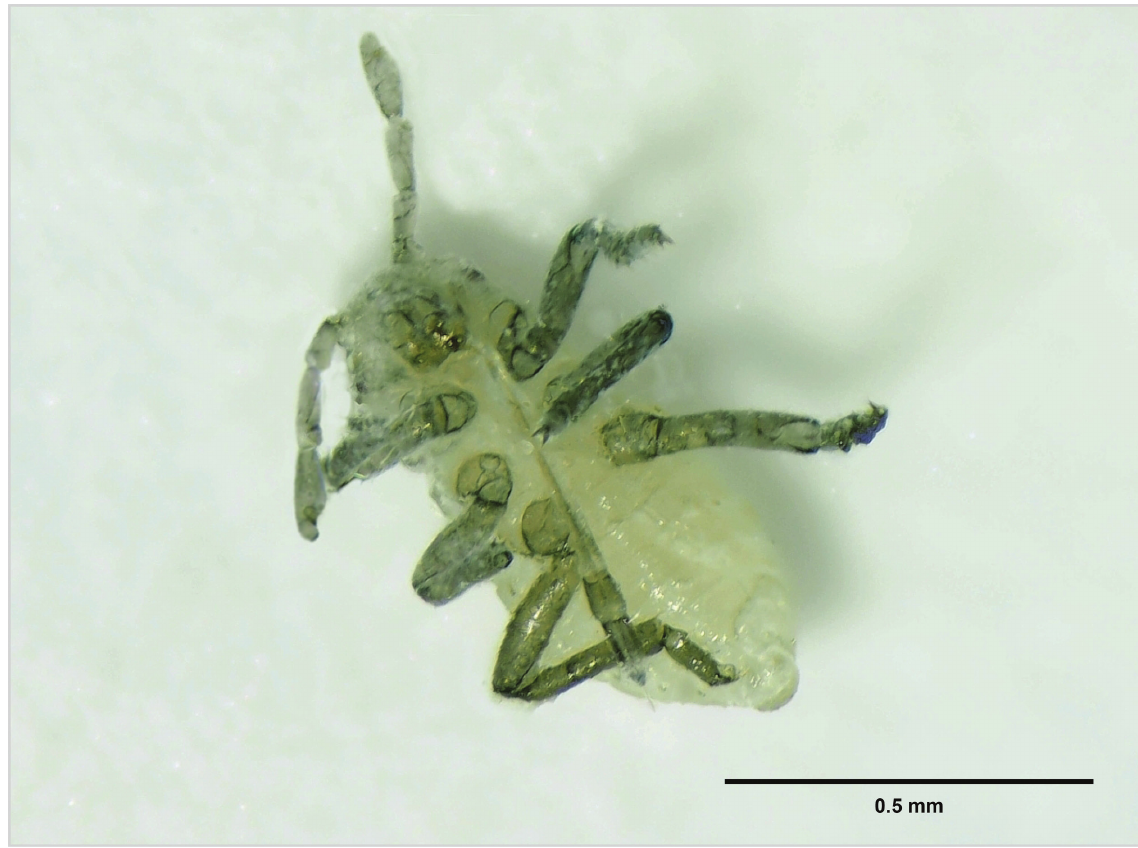
Fig. 20. Pachypappa populi (linnaeus, 1758). Apt. from mycorrhizal Picea abies root in the moor layer of a shady spruce